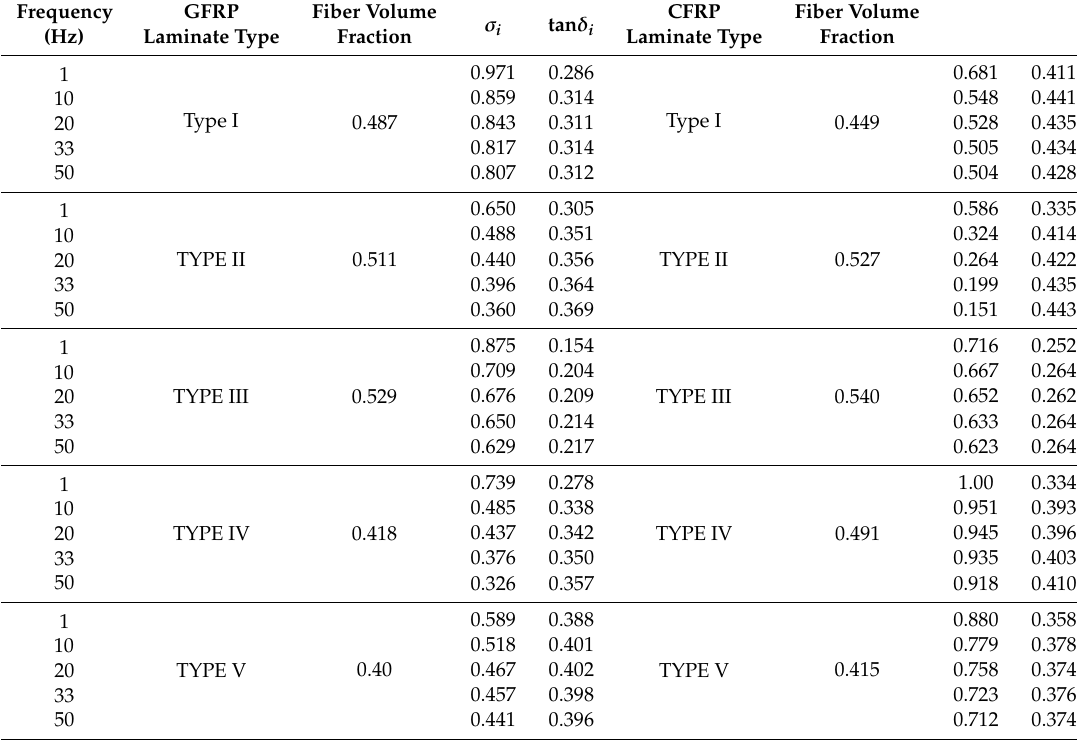
Table 5. Strength indicator and interfacial damping parameters of GFRP and CFRP